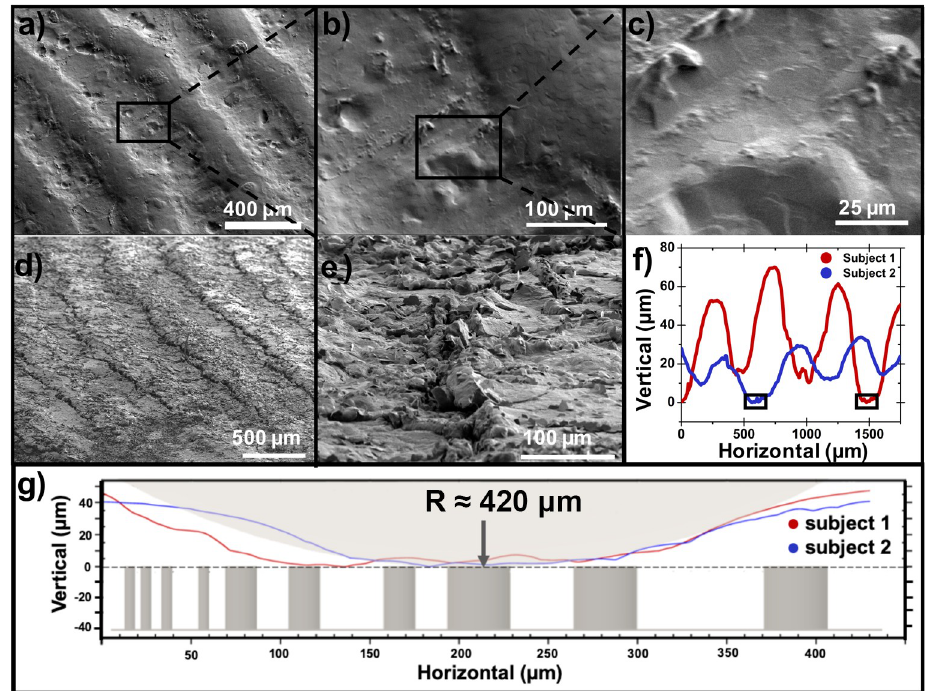
Fig 5. Topology of human finger pads. Panels (a) through (c) are SEM images of a paraffin mold used to cast the PDMS replica finger probes used in this study, shown at sequentially higher magnification. Note that because this mold is a negative image from which the replica finger probe is cast, pits and depressions within the lower regions represent asperities that protrude from the fingerprint ridges of the probe. Panels (d) and (e) are SEM images of a 30:1 PDMS probe at the conclusion of testing. Panel (f) shows profilometry traces of fingerprint molds from two authors to demonstrate the general dimension and variability of human fingerprints where the single ridge rectangular insets are then plotted in (g) with equally scaled axes to convey the true extent of microroughness in contact with the micropillar arrays.